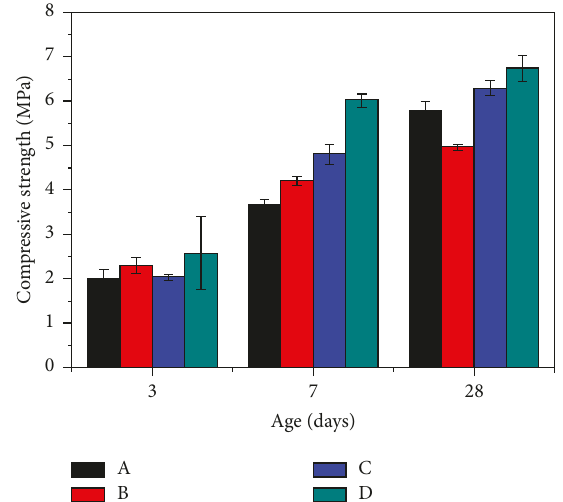
Figure 1: Effect of liquid type (a) deionized water; (b) reaction solution; (c) bacterial suspension; (d) bacterial suspension and reaction solution on the compressive strength of cement cubes amended with 20% bentonite after 3, 7, and 28